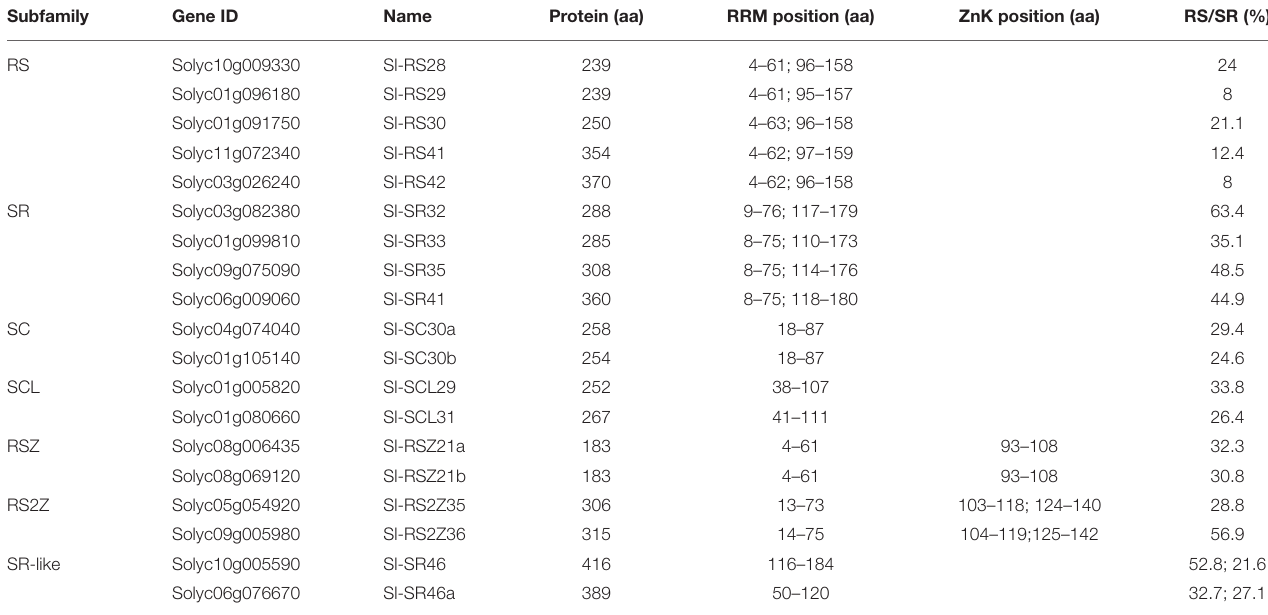
TABLE 1 | List of tomato SR proteins and position of their domains.